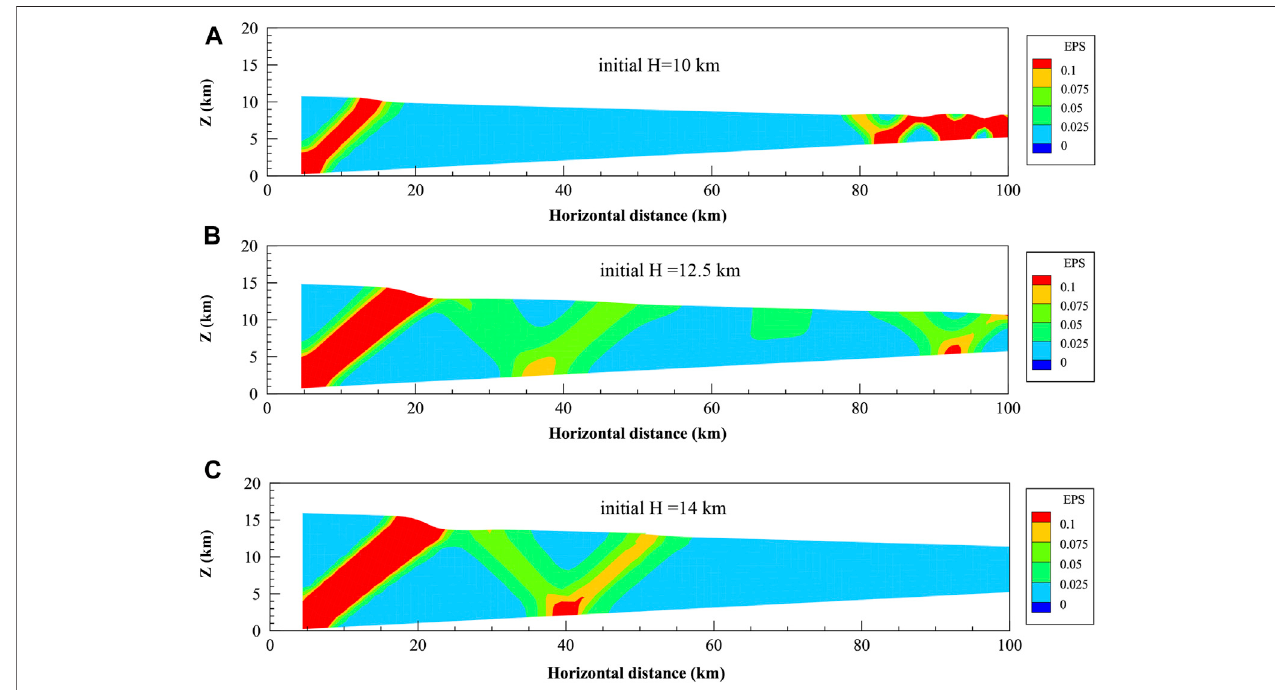
FIGURE 12 | Final state EPS for models with different initial decollement depths (H). After 4.4 km ofshortening displacement, panels (A – C) show states of models 13, 1, and 14, which started withinitial left-end depths ofshallow inner-crust decollementof (10, 12.5, and 14) km, respectively (but these left-end depths have become largerafter4.4 kmshorteningdeformation).Plasticityconcentrationpatternsaredifferentamongthem.Allofthemexhibitplasticityinwedgethickerregion,butimportant plastic deformation in thinner region manifests only for overall thinner layers (shallow decollement).